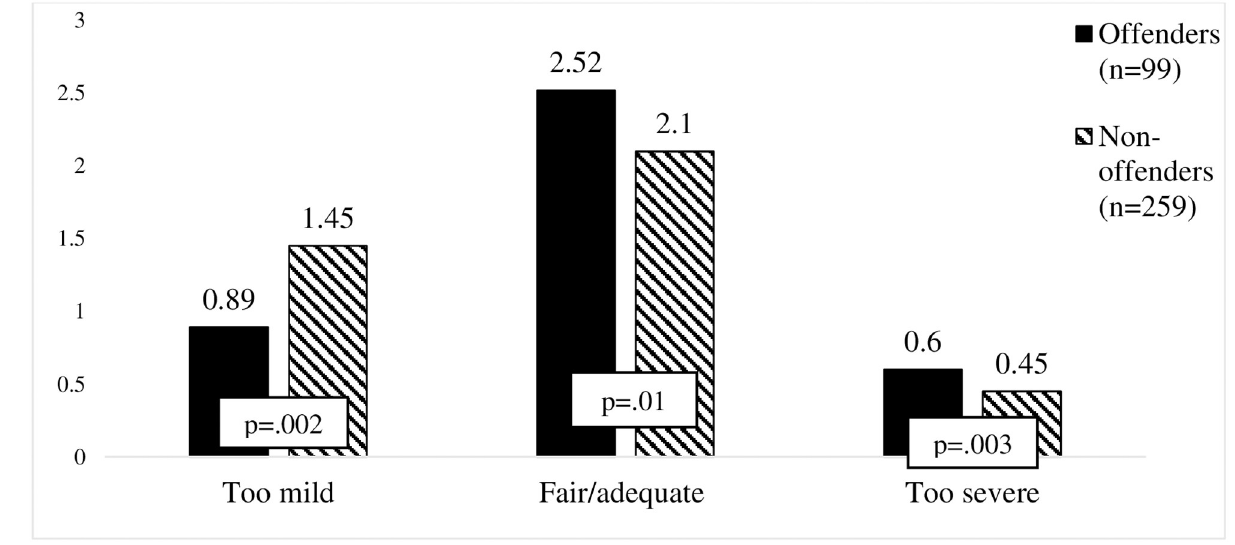
Fig 3. Illustration of differences in evaluation of penalties for speeding among offenders and non-offenders.